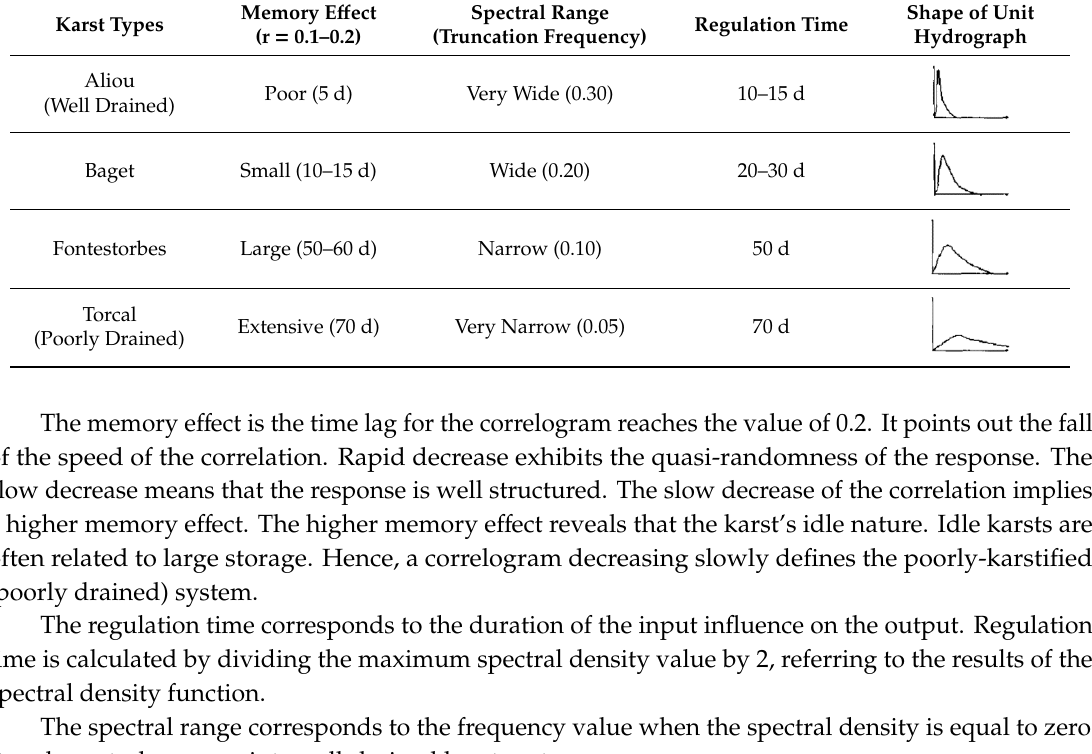
Table 2. Karst aquifer classification proposed by Mangin